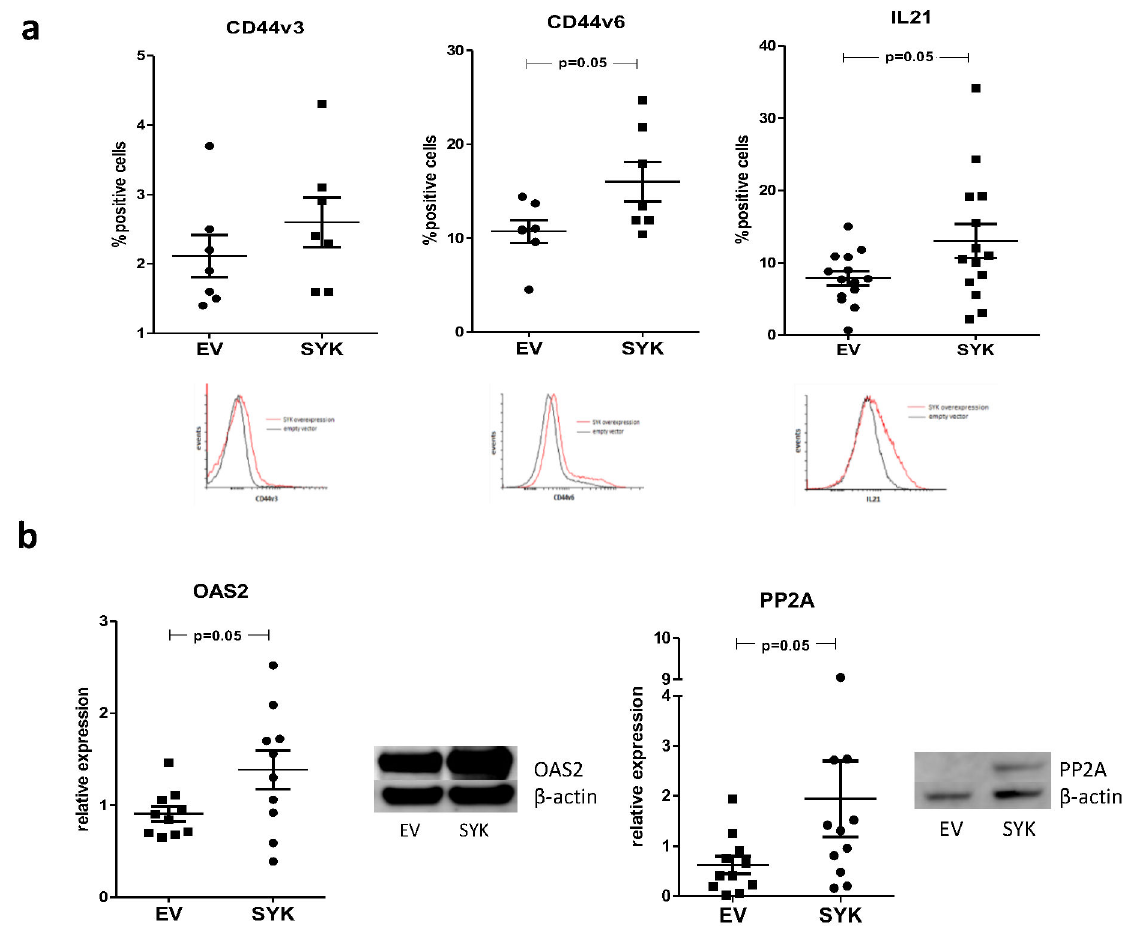
Figure 3. Induced Syk expression upregulates expression levels of SLE-associated molecules in healthy blood donor T cells. a) SYK was overexpressed in healthy blood donor T cells using a transient nucleofection protocol and expression levels of IL-21, CD44v3 and CD44v6 measured in flow cytometry. SYK overexpression resulted in the upregulation of the expression of all these molecules at the protein level. Changes in expression of variant v6 of CD44 molecule seemed to account for most of the changes seen at the mRNA level (bars show the mean ±SEM of SYK (SYK) vs. empty vector (EV) transfected T cells in ≥7 experiments). b) Following the same transfection protocol cells were lysed in RIPA buffer and subjected to western blot using antibodies against PP2a, OAS2 and β-actin. Protein expression levels of both OAS2 and PP2a increased significantly following SYK induced expression. Following measurement of band intensity the ratio of PP2a or OAS2 to β-actin was calculated in each experiment (a representative experiment and cumulative data (mean ± SEM) from 10 experiments are shown). doi: